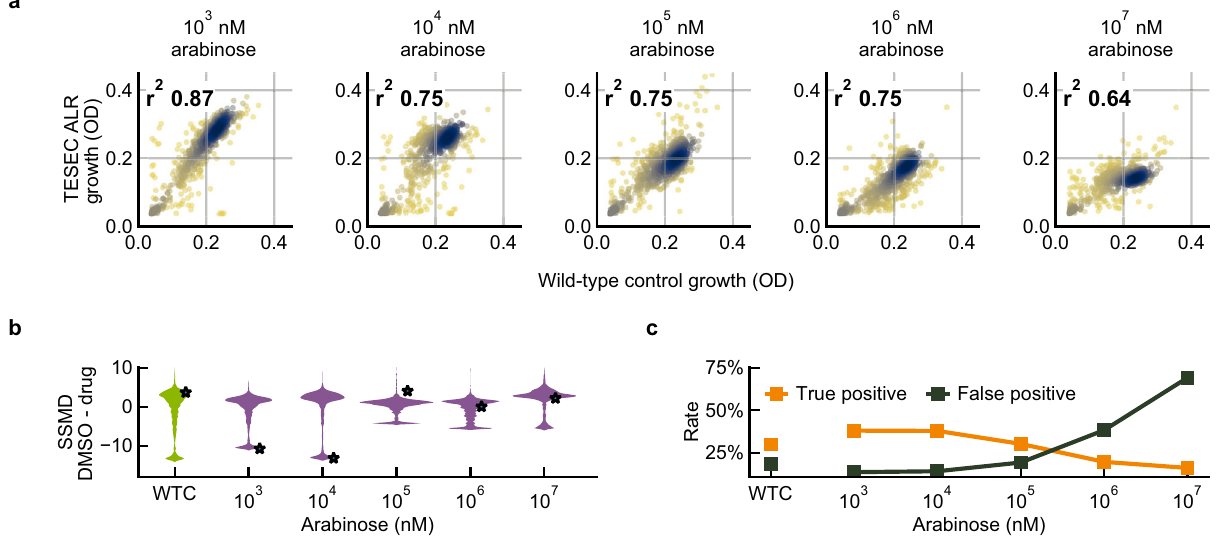
Fig. 3 Chemical-genetic drug sensitivity is signi fi cantly altered by target overexpression. a The growth effects of 1280 drugs from the Prestwick library on the TESEC Mtb Alr expression strain induced with varying levels of arabinose and the TESEC Alr + wild-type control. Points are colored to indicate point density and r 2 is the Pearson correlation coef fi cient. b A violin plot of SSMD values comparing triplicate measurements of growth inhibition under drug treatment with growth measured in DMSO-only controls. High induction levels were associated with lower growth signal and higher noise resulting in less robust differentiation between inhibiting and non-inhibiting compounds. c Sensitivity of the TESEC assay in detecting the 183 known antibiotics in the Prestwick library. Predicted antibiotics were compounds showing more than 50% growth inhibition relative to DMSO controls. High induction levels were associated with lower growth, weaker signal, and more false positives. Source data are provided as a Source Data fi